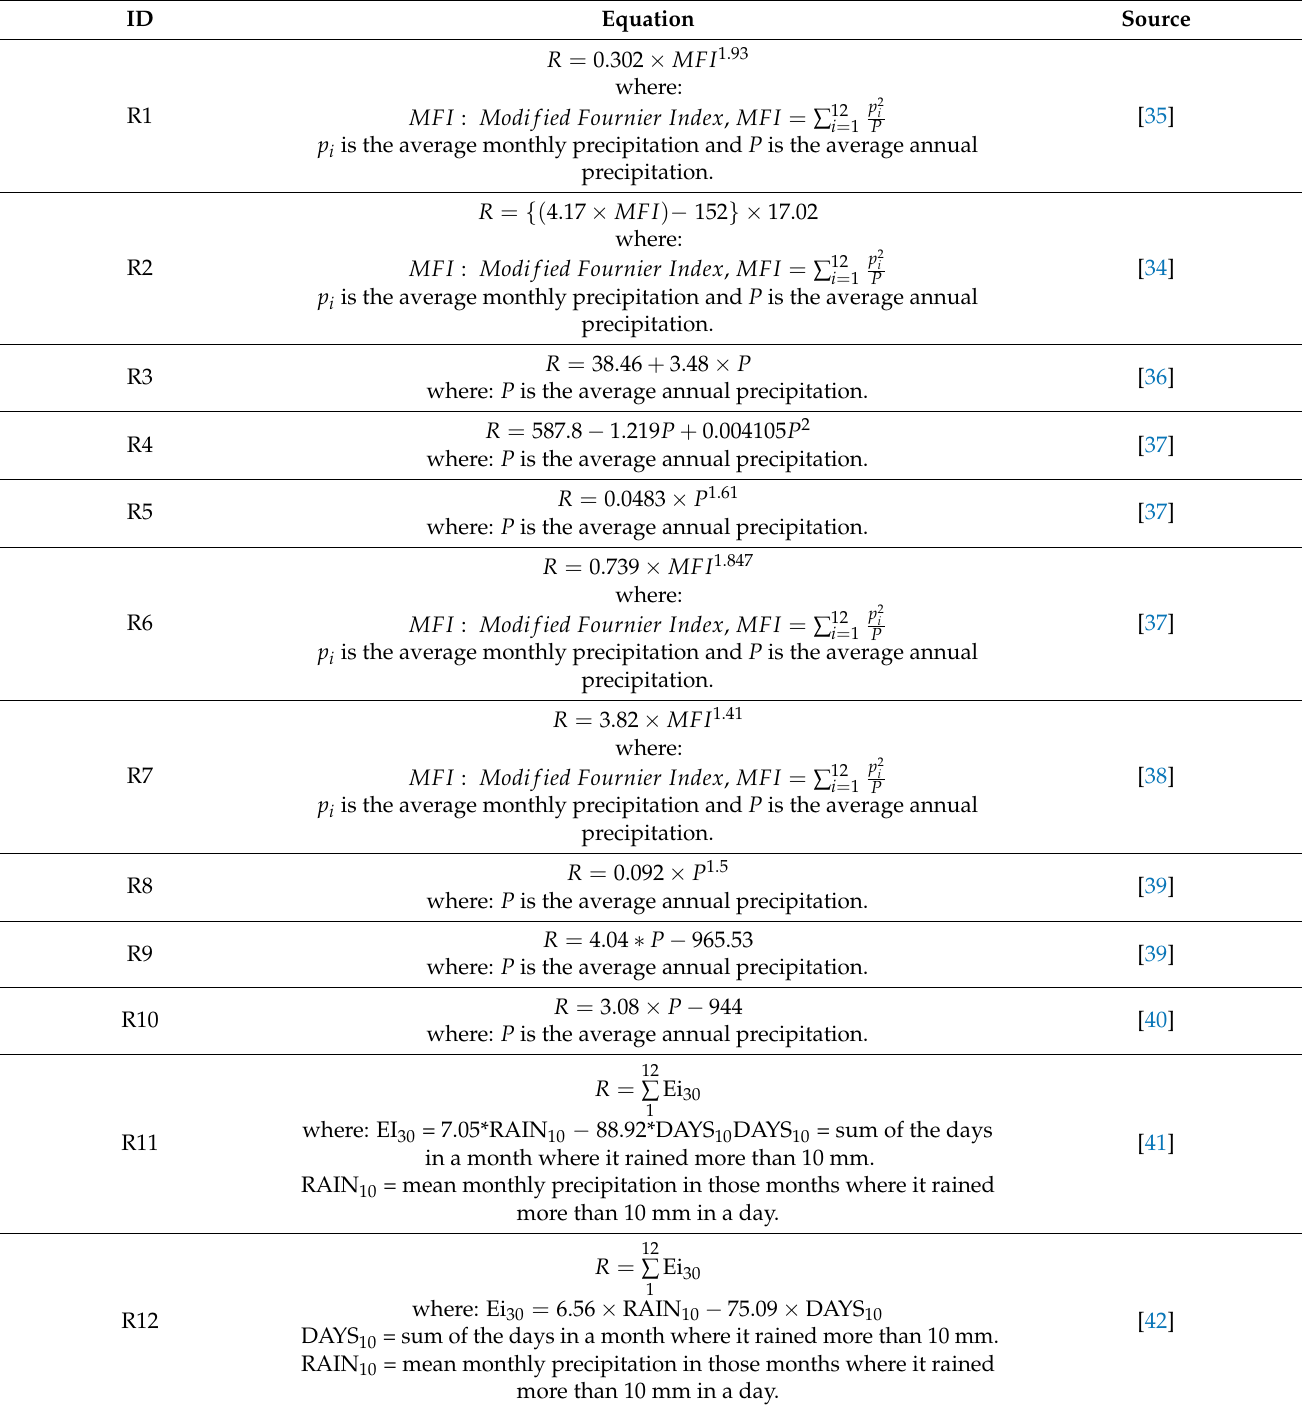
Table 1. Rainfall erosivity equations used in this